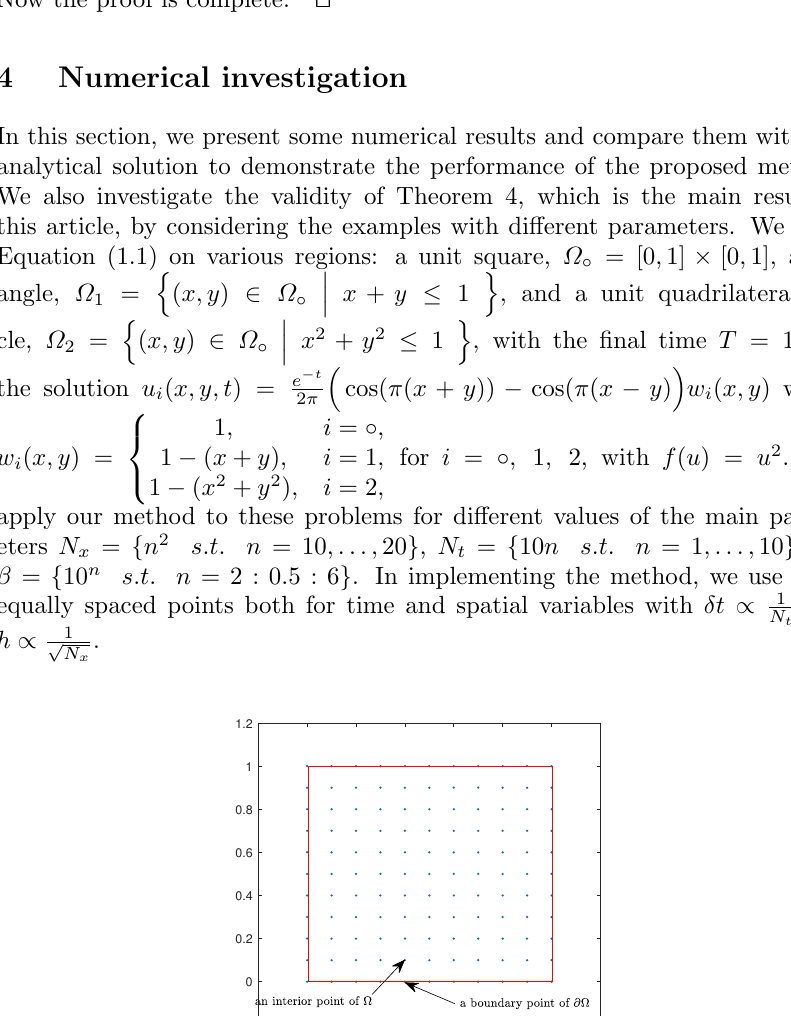
Figure 1. The Galerkin method is used with the radial basis function φ ( r, c )